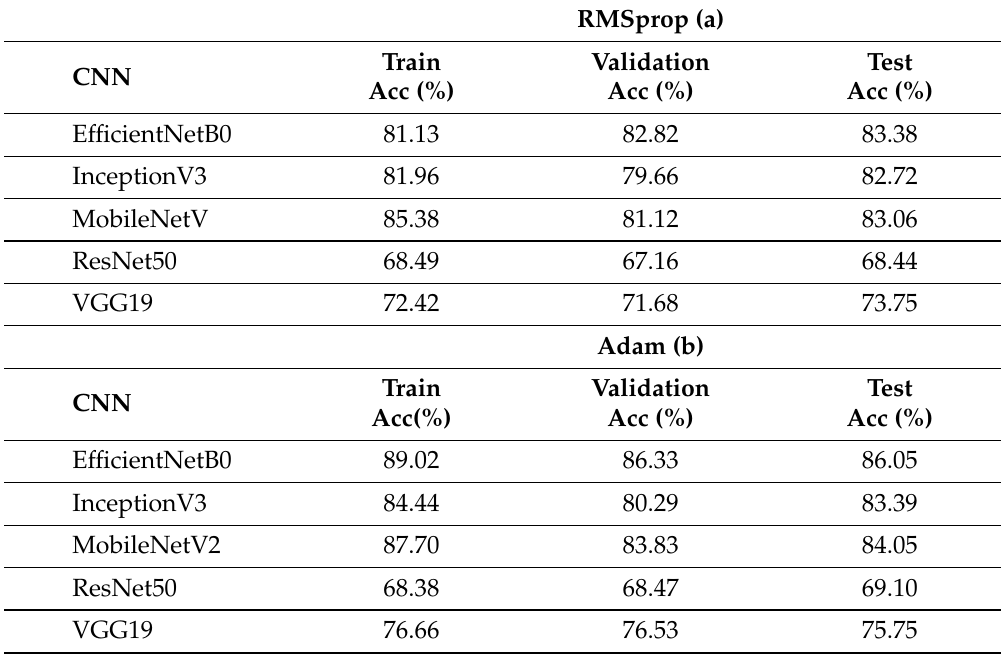
Table 4. Accuracies obtained with RMSprop (a) and Adam (b) optimizers, respectively, in the training set, validation set and test set in the task of classifying the “healthy”, “slug”, “curl” and “spot” classes.